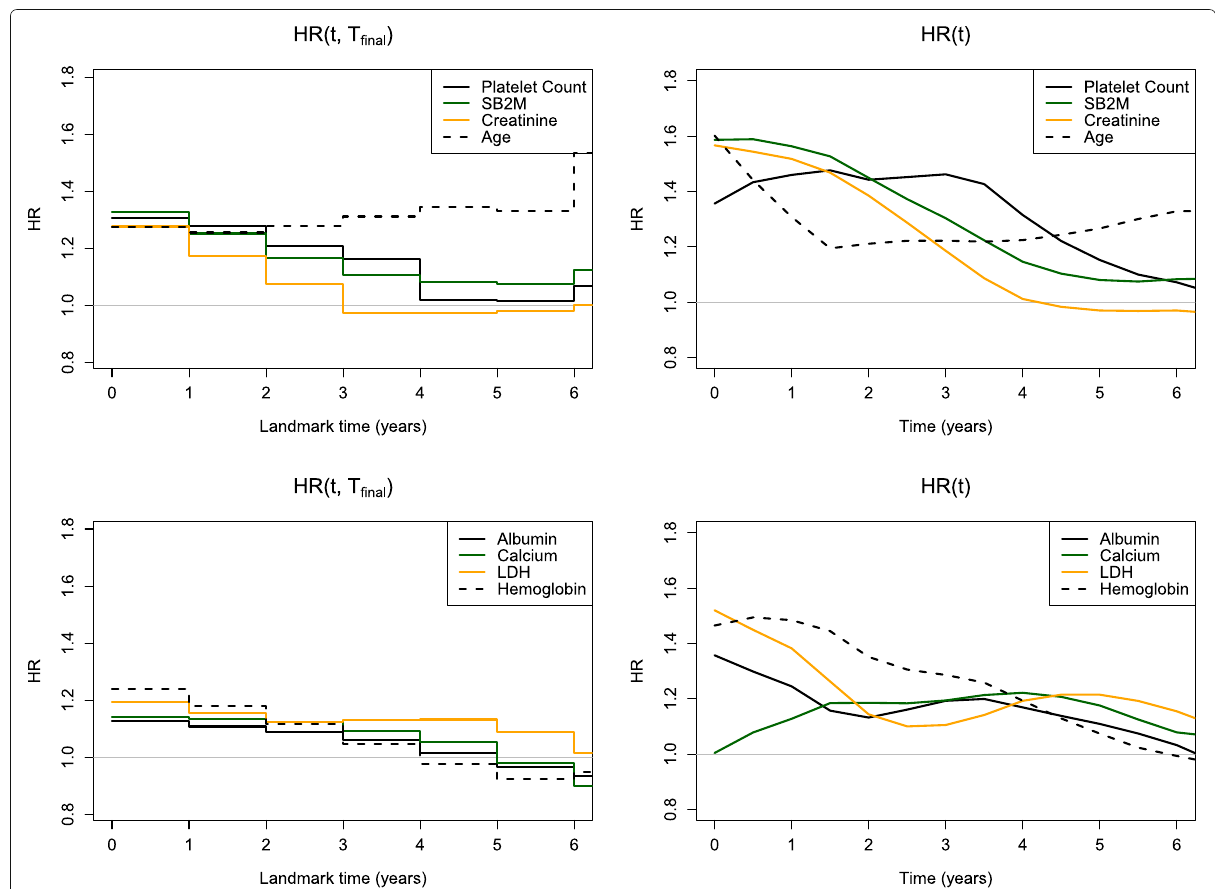
Fig. 3 Marker performance over time using hazard ratios from landmark analysis and local linear estimation. The markers have been split up into two sets displayed in the top panel (platelet count, SB2M, creatinine, and age) and the bottom panel (albumin, calcium, LDH, and hemoglobin) for clarity. This figure appears in color in the electronic version of this article